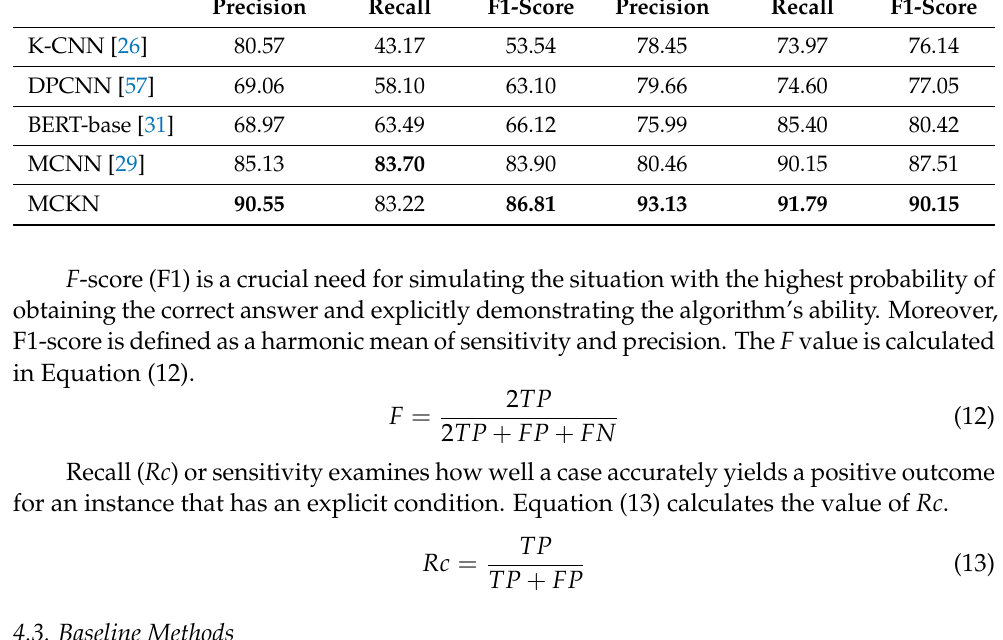
Table 3. Performance comparison of MCKN with state-of-the-art approaches. Training Dataset Bootstrapped Dataset Models Precision